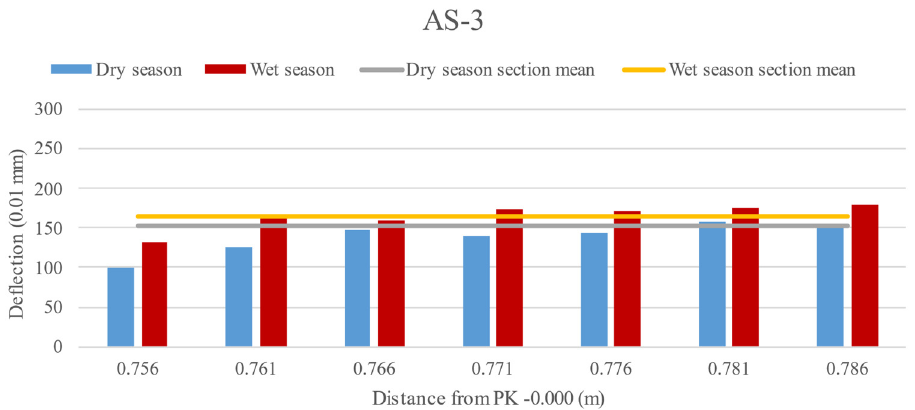
Figure 14. Deflection measurement in AS-3.